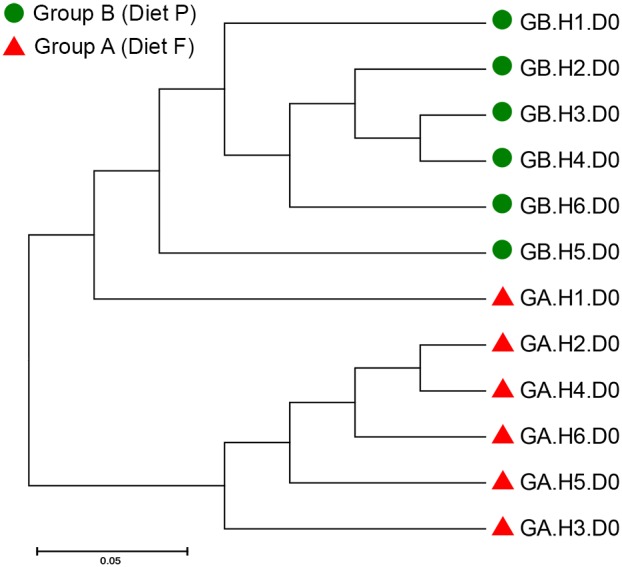
UPGMA dendrogram based on the Bray-Curtis dissimilarity matrix on Day 0.The Bray-Curtis dissimilarity metric takes into account the presence and absence of taxa and the relative abundances of the taxa, to generate a dissimilarity matrix for the faecal microbiota present in samples from horses on Day 0. The UPGMA dendrogram shows distinct clustering of horses (H; numbered from 1–6 per group) by group, indicating that the faecal bacterial community structure of horses on Day 0 differed between Group A (GA) and Group B (GB), which were fed Diet F and P respectively.